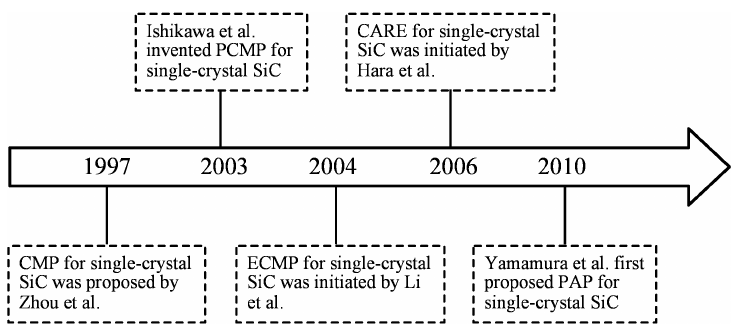
Figure 1. The development process of precision polishing technology of single-crystal SiC.